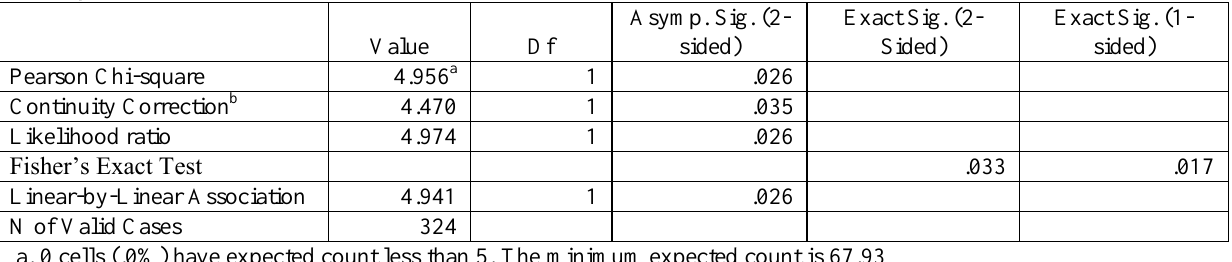
Table 4a: Respondents’ satisfaction with the airlines’ service and whether they have formed a long-term relationship with the airlines Chi-Square Tests